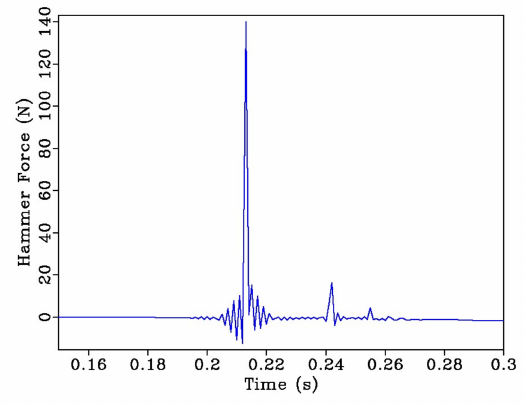
Figure 8. Sample of a typical hammer impact